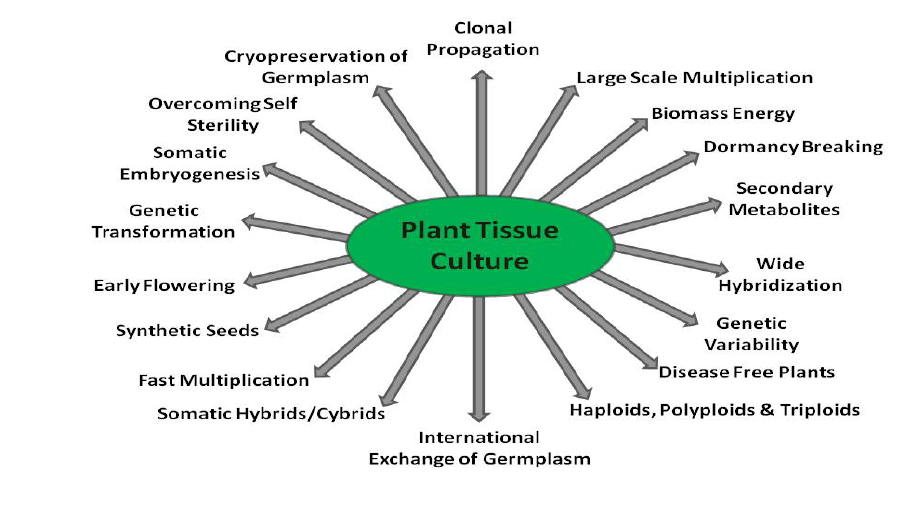
Figure 2: Different use and prospective of plant tissue culture Applications of plant tissue